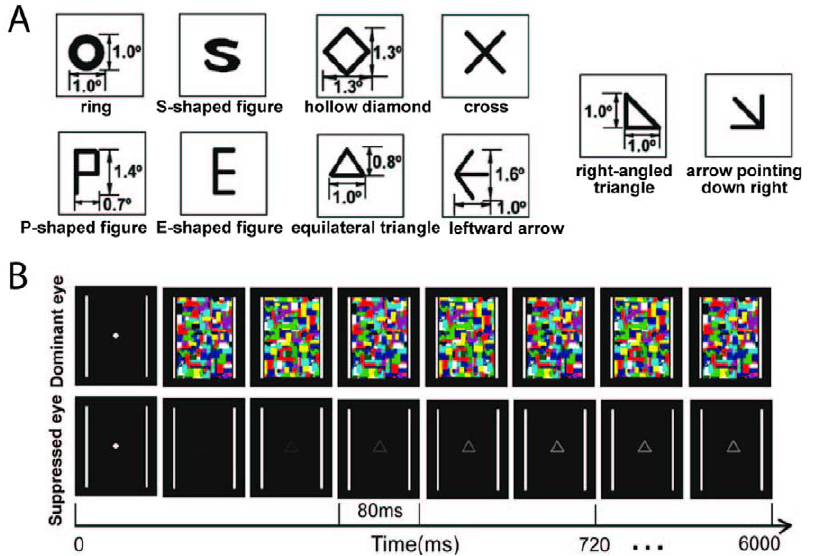
Figure 1. Stimuli and Procedures. (A) Schematic depiction of the stimulus pairs. (B) Schematic representation of the binocular rivalry paradigm.